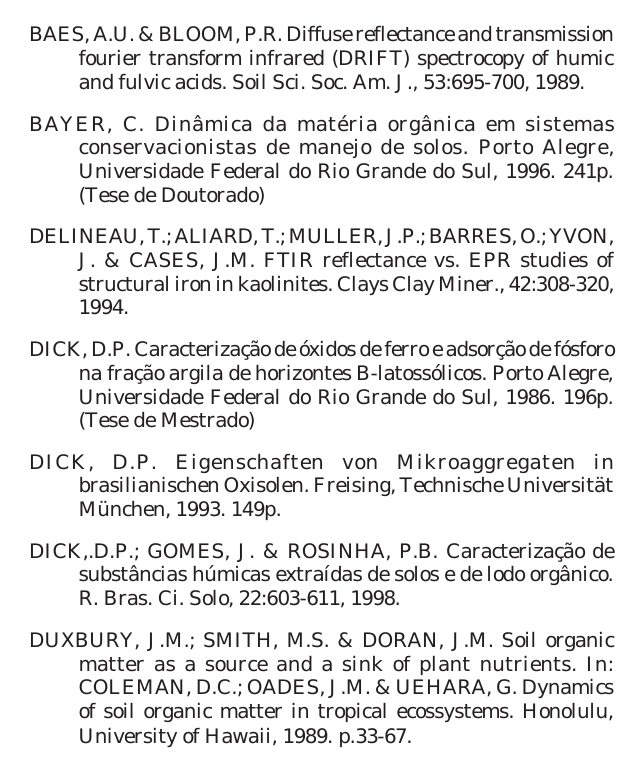
Figura 4. Espectro de DRIFT do LR tratado com oxalato de amônio a) antes e b) depois da adsorção de ácido húmico extraído de